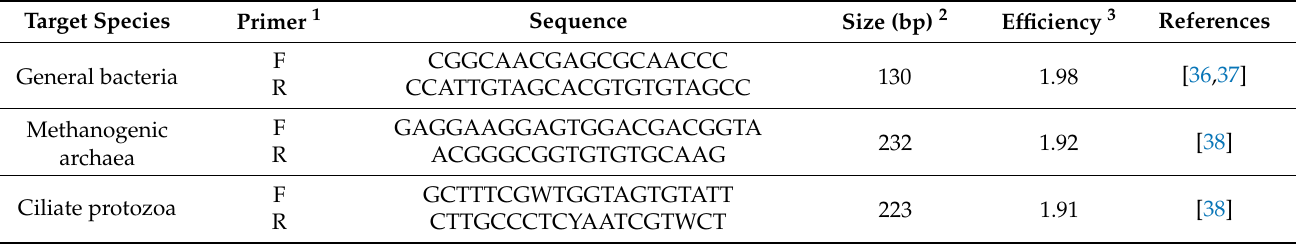
Table 2. Primers for real-time polymerase chain reaction